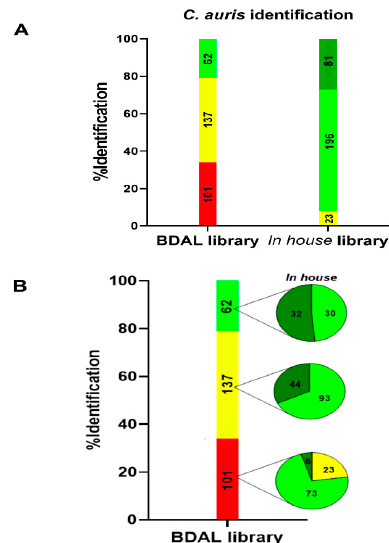
Figure 4. BDAL and Candida auris Colombia libraries’ identification results. ( A ) Total results independently obtained from each library. ( B ) Yeast comparison identification from BDAL and Colombia